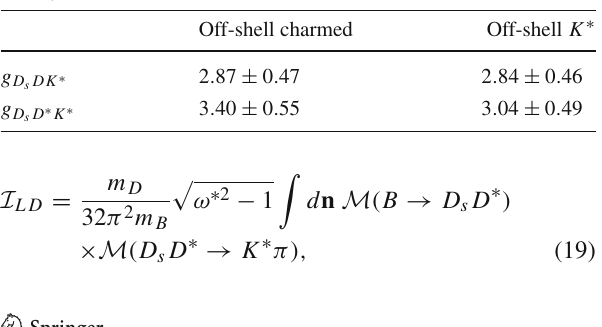
Table 6 The coupling constants of the vertices D s DK ∗ and D s D ∗ K ∗ , in SU f ( 3 ) symmetry